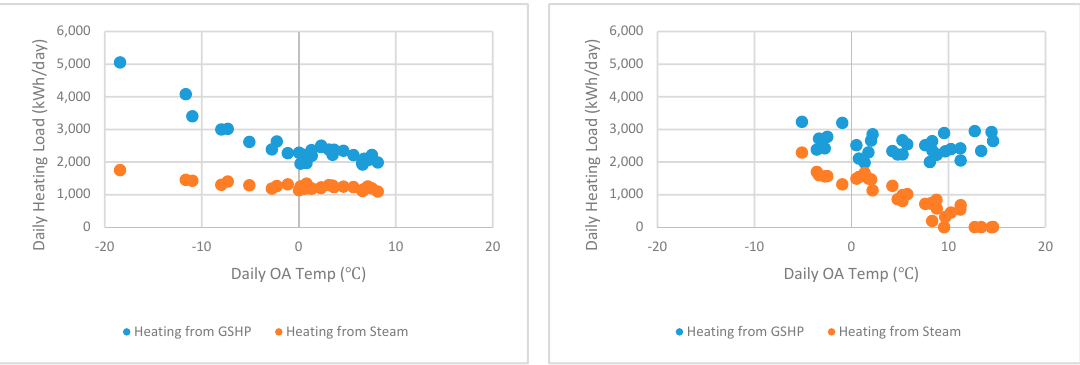
Figure 6. Daily heating outputs before ( left ) and after ( right ) the control change.